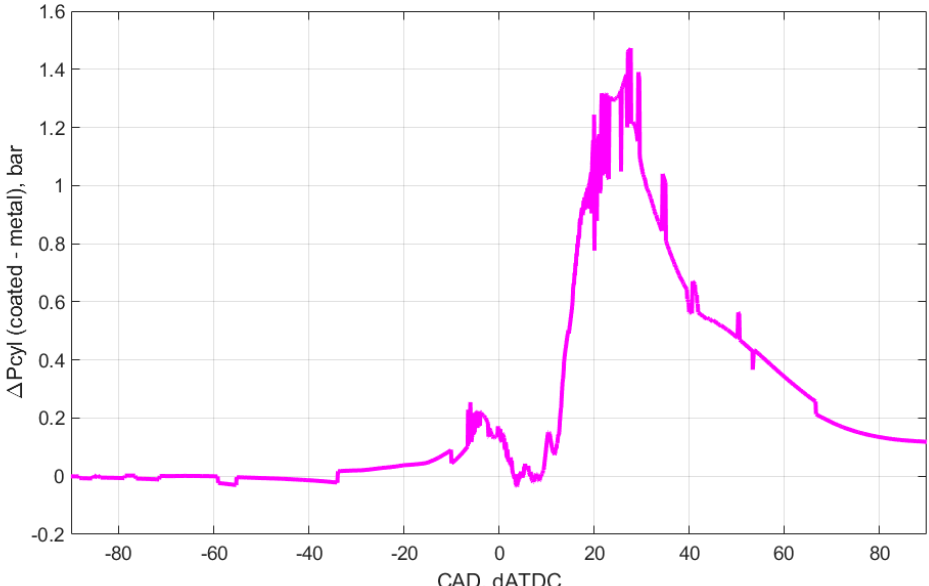
Figure 5. Cylinder pressure delta from the full load metal and TBC cases. The positive nature after combustion indicates that the coated piston simulation had a higher in-cylinder pressure from ≈ 10 degrees after top dead center to well after 80 degrees after top dead center. Consequently, expansion work can be expected to increase with the TBC.